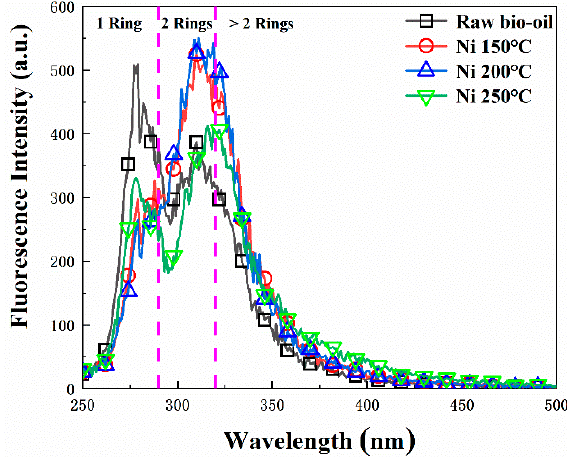
Figure 10. UV fl uorescence spectra of bio-oil Pickering emulsion hydrodeoxygenation at 150 °C, 200 Figure 10. UV fluorescence spectra of bio-oil Pickering emulsion hydrodeoxygenation at 150 ◦ C, °C, and 250 °C. 200 ◦ C, and 250 ◦